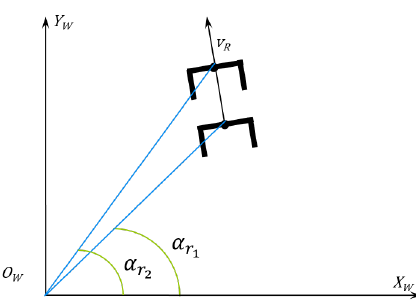
Figure 10. Variation of the robot in the absolute reference and calculation of the angular speed.